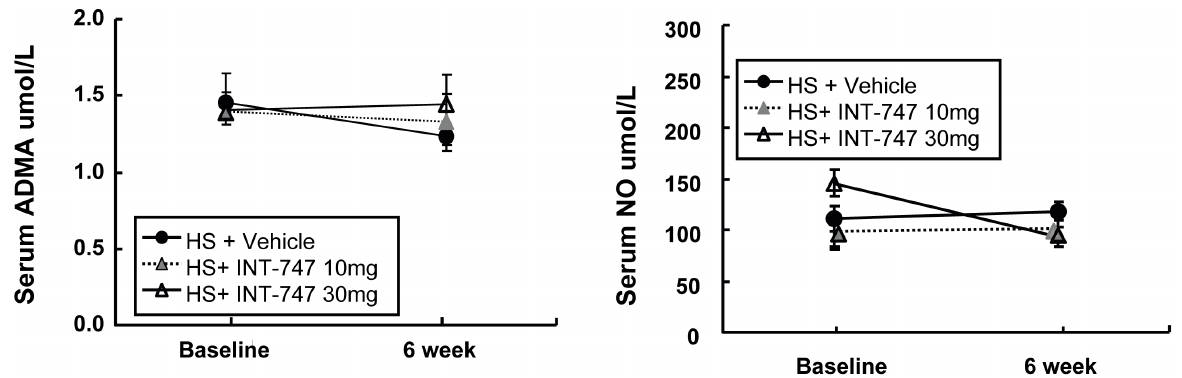
Figure 5. Measurements of serum ADMA and NO in Dahl rats at baseline and 6-weeks after feeding high-salt diet in the presence of vehicle or INT-747 treatment. NO and ADMA were measured as described in the text. Data is expressed as Mean 6 SEM. NO=nitric oxide; ADMA=asymmetric dimethylarginine.